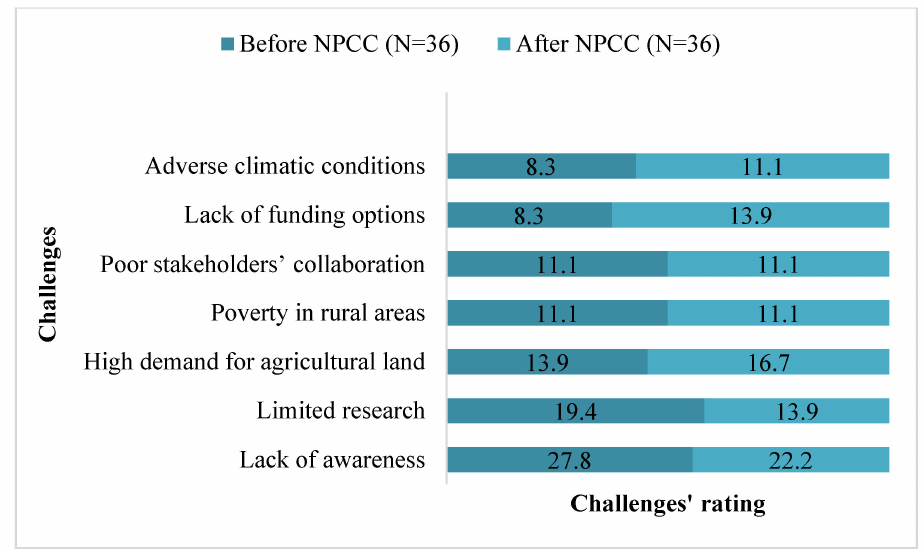
Figure A1. Challenges in the implementation of adaptation actions before and after the NPCC. Challenges’ ratings are presented as %.